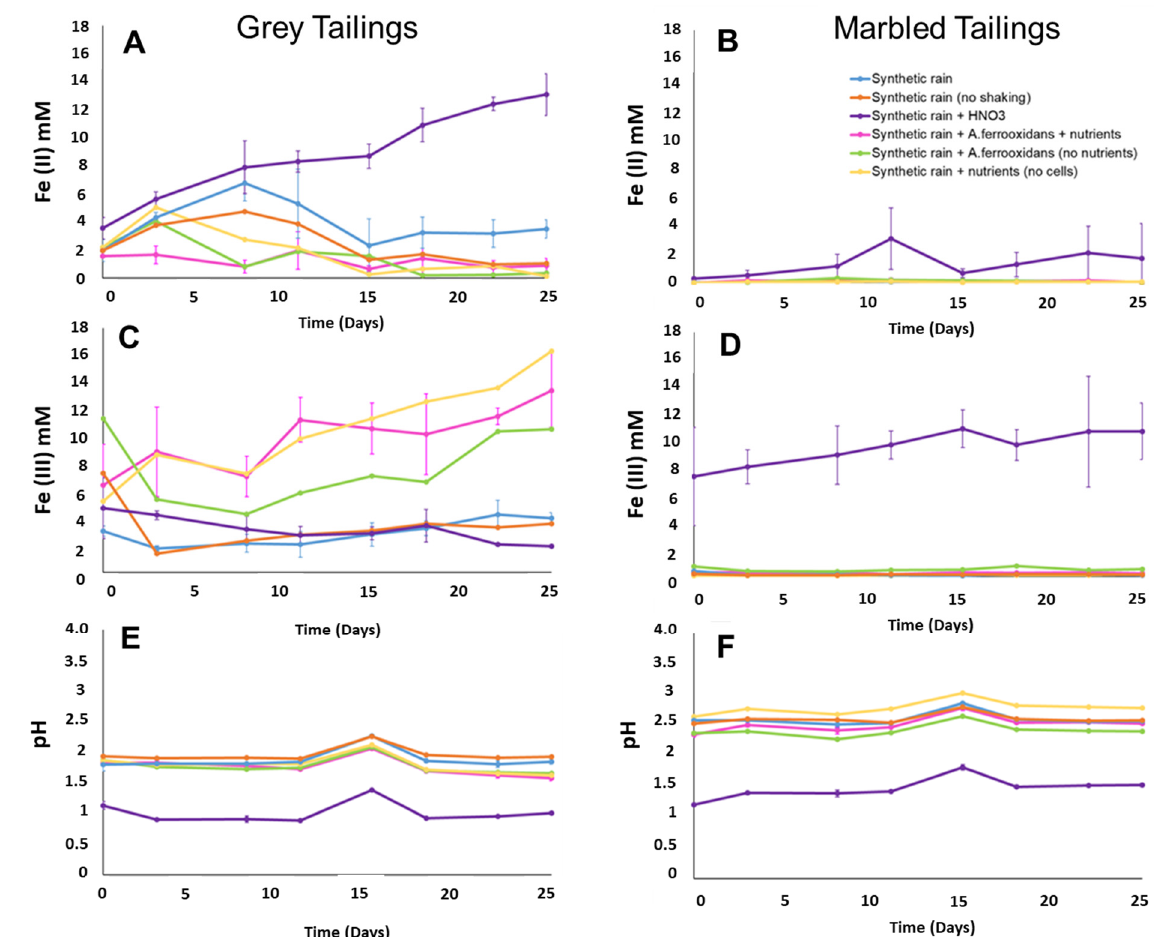
Figure 5. Monitoring data from the oxidation experiments. Physical oxidation compares shaken (blue) with no shaking control (orange). Chemical oxidation compares nitric acid addition (purple) with no acid addition (blue). Biological oxidation compares inoculating with cells and nutrients (pink) against controls with cells and no nutrients (green) and nutrients with no cells (yellow). Experimental data are the average of three replicates, error bars ± 1 standard deviation. Controls are single measurements. ( A ) Fe(II) in Grey Tailings. ( B ) Fe(II) in Marbled Tailings. ( C ) Fe(III) in Grey Tailings. ( D ) Fe(III) in Marbled Tailings. ( E ) pH in Grey Tailings. ( F ) pH in Marbled Tailings.